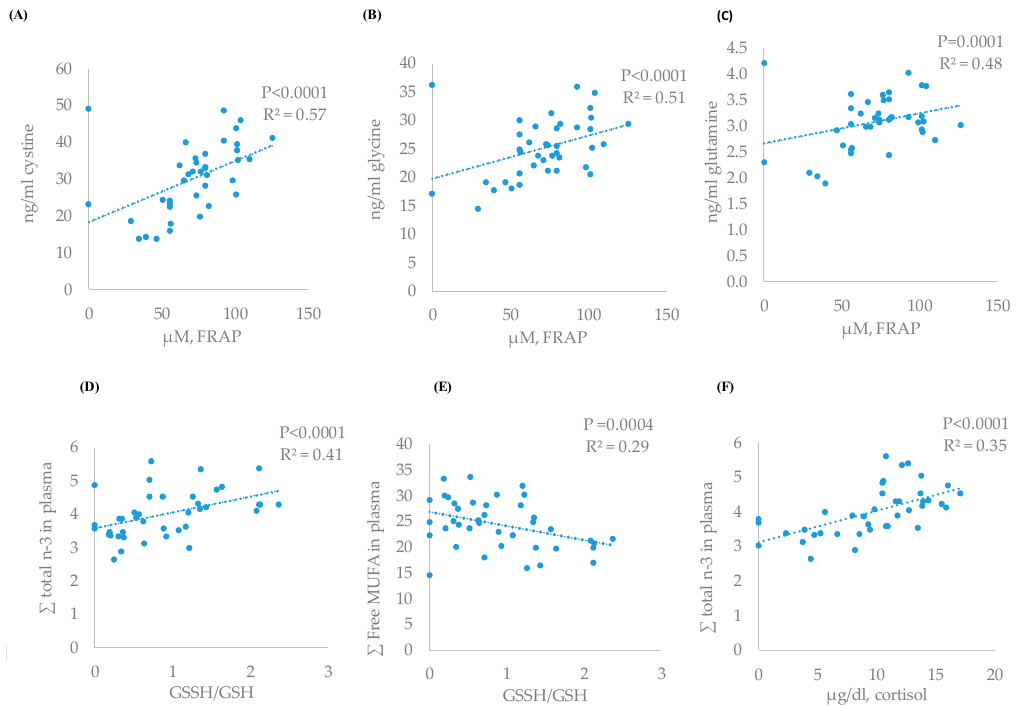
Figure 2. Relationship between antioxidant status and amino acids or fatty acid profile (linear): FRAP and cystine ( A ), FRAP and glycine ( B ), FRAP and glutamine ( C ), GSSH / GSH and n-3 ( D ), GSSH / GSH and free MUFA ( E ), and cortisol and n-3 fatty acids ( F ) of the experimental